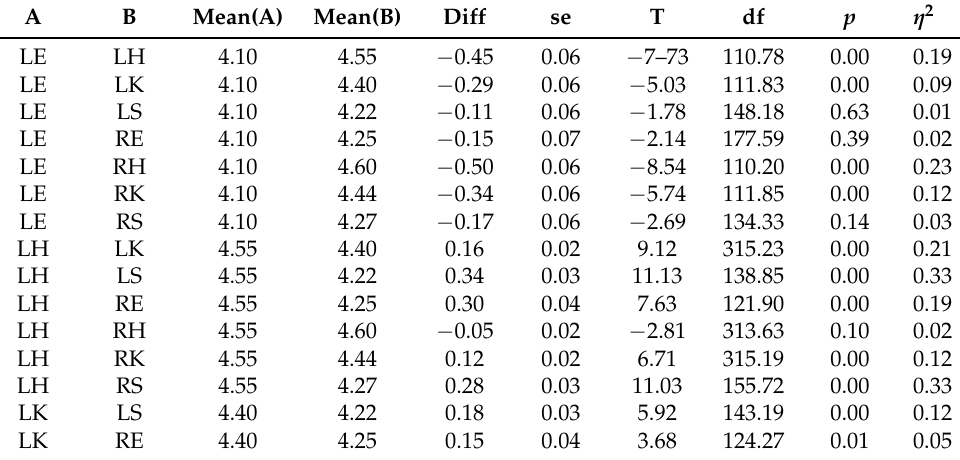
Table A2. The results of the ANOVA Post-hoc analysis of the ME for the eight angles left elbow (LE), left hip (LH), left knee (LK), left shoulder (LS), right elbow (RE), right hip (RH), right knee (RK), and right shoulder